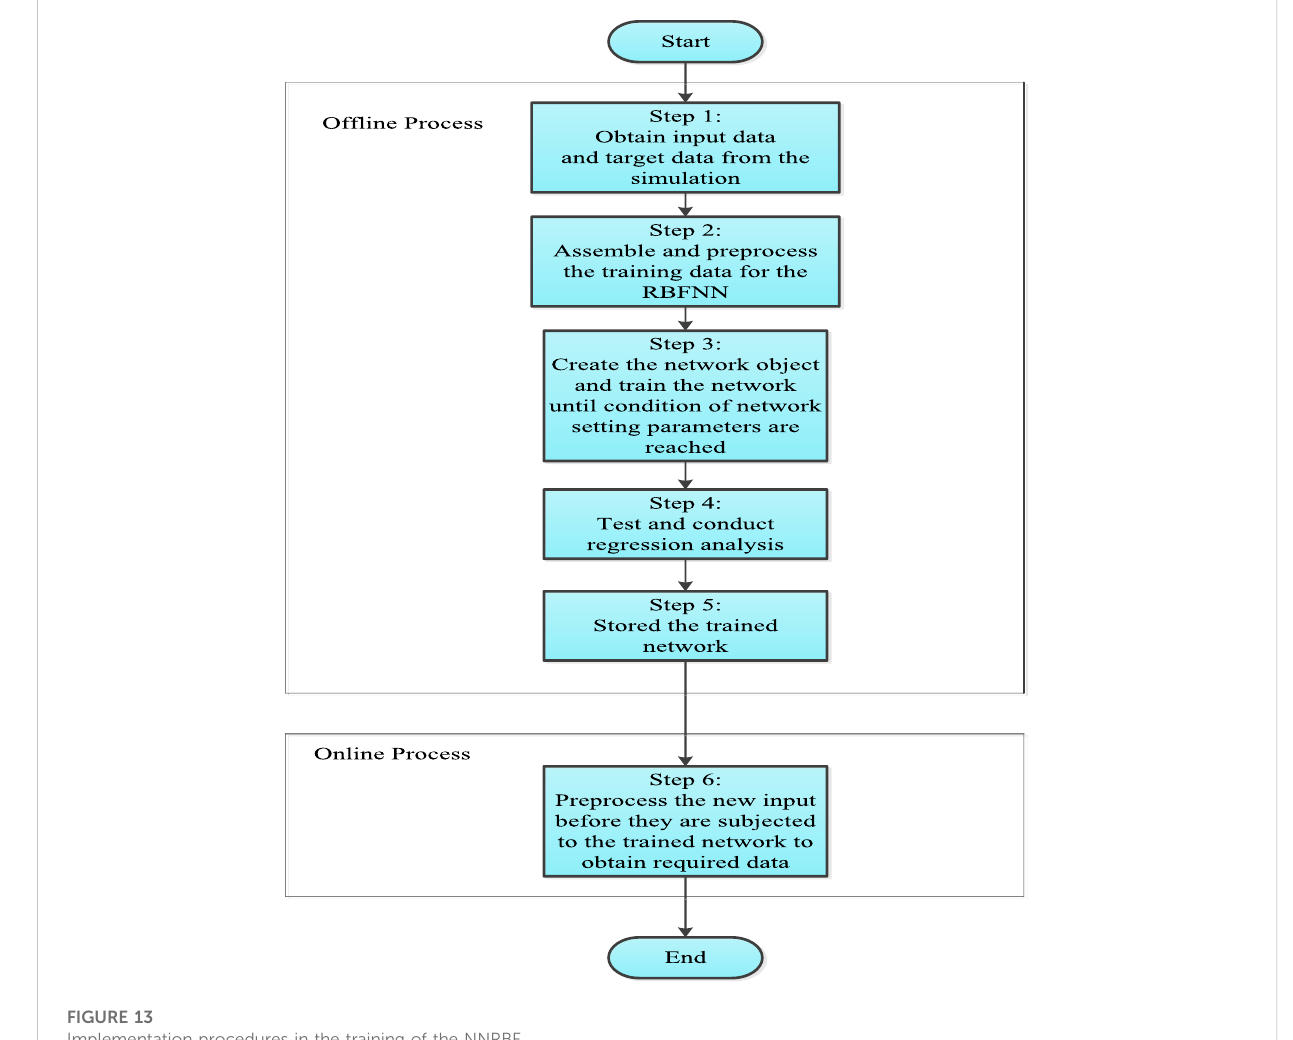
FIGURE 13 Implementation procedures in the training of the